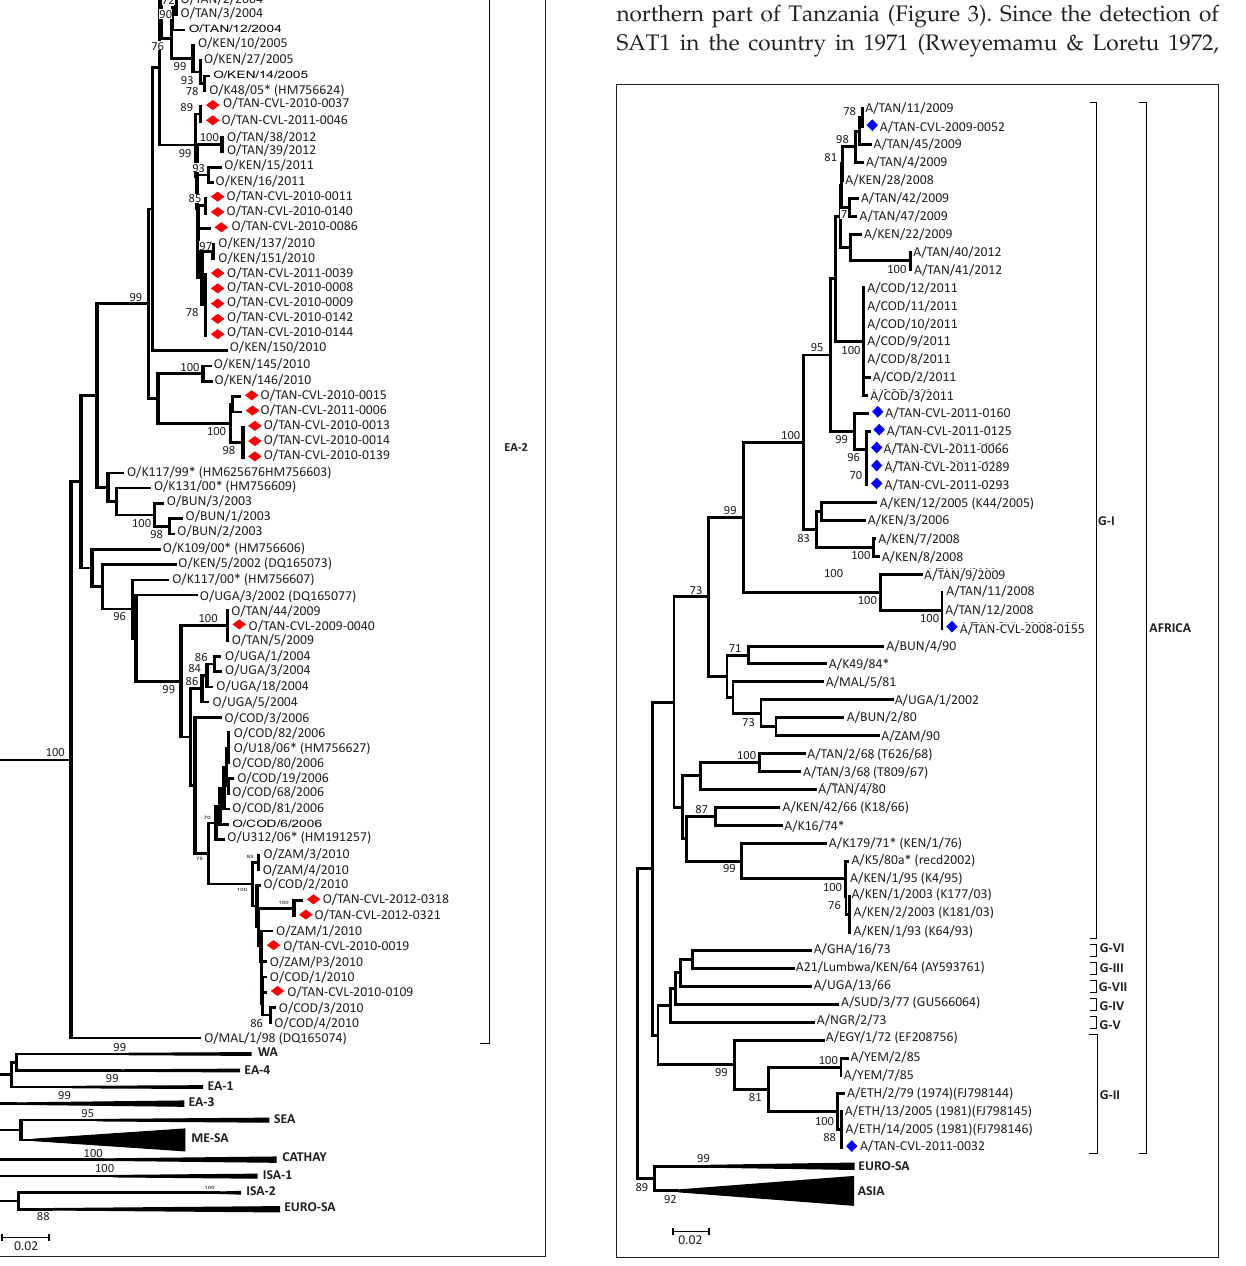
FIGURE 2: Midpoint-rooted neighbour-joining tree (based on the complete virus protein 1 coding sequence) showing the relationships between the foot- and-mouth disease virus serotype A isolates from Tanzania (see blue coloured diamonds) and other contemporary and reference